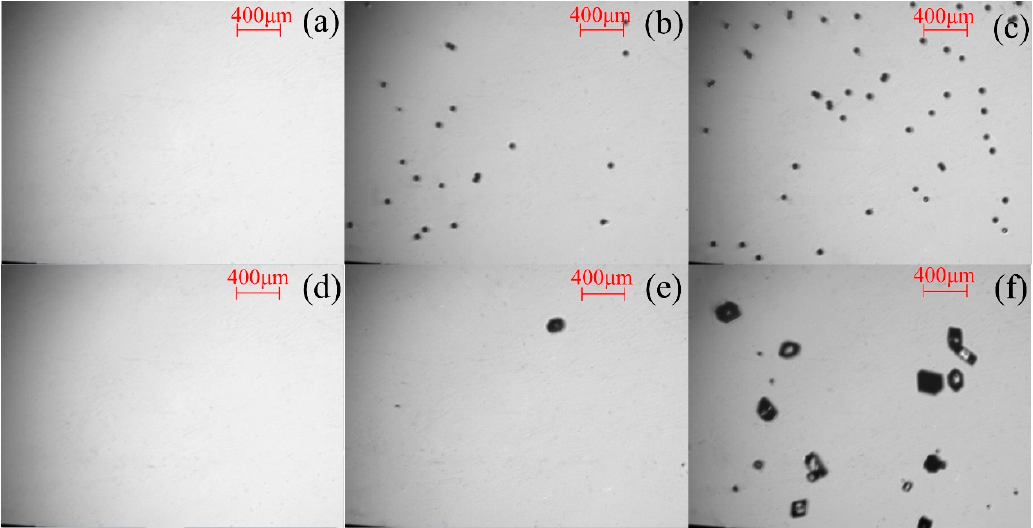
Figure 1. Images of polystyrene microspheres and 2,2-azobisisobutyronitrile (AIBN) crystals during the nucleation process. ( a – c ) Images of polystyrene microspheres at mass fractions of 0, 56.9, and 97.9 mg / 250 mL, respectively. ( d – f ) Images of AIBN crystals during the secondary nucleation process.